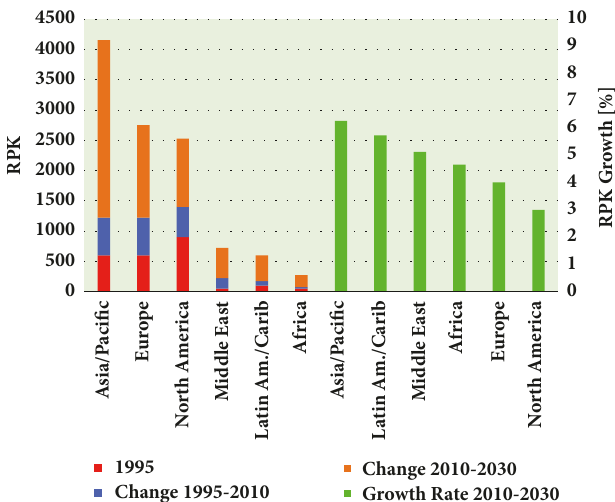
Figure 1: ICAO passenger traffic forecast by ICAO statistical region [9].